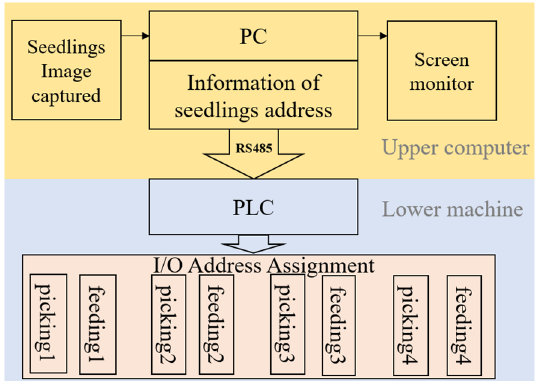
Figure 4. Illustration of the control system.